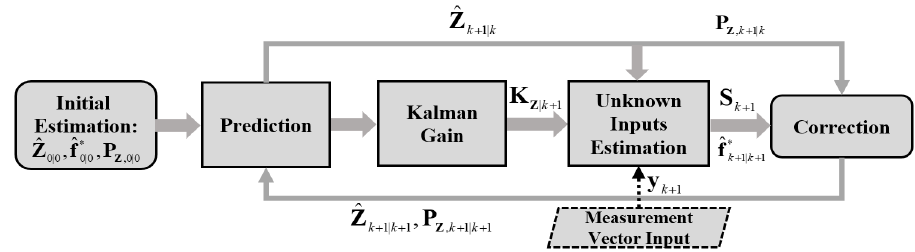
Figure 1. Flowchart of the EKF-UI